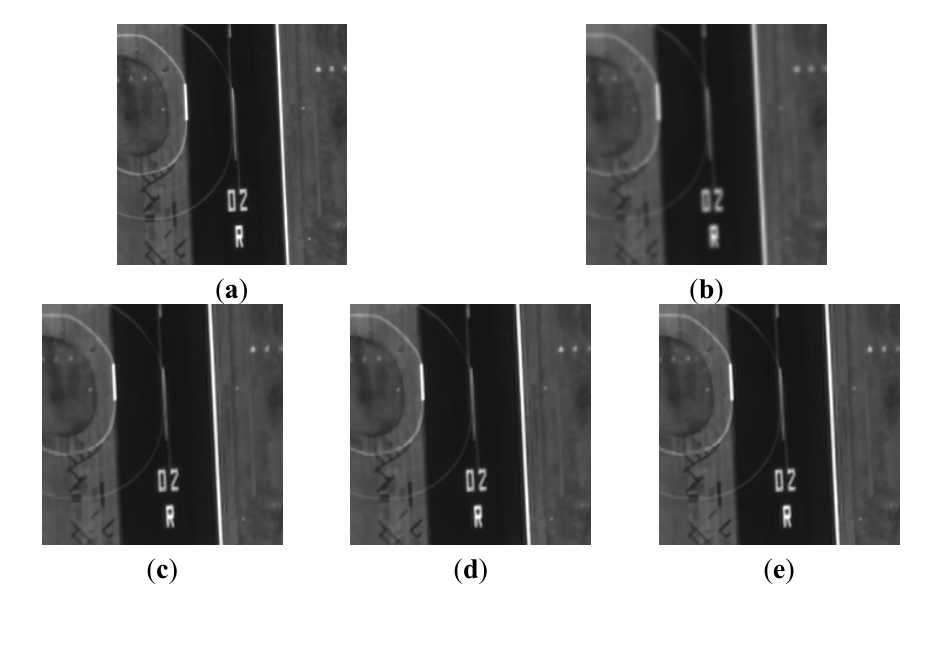
Figure 6. Experimental results of different resolution enhancement methods with Image1. ( a ) Original HR image; ( b ) bilinear interpolation; ( c ) general algorithm (GEN); ( d ) angle weighted (ANGW); ( e ) residual error weighted